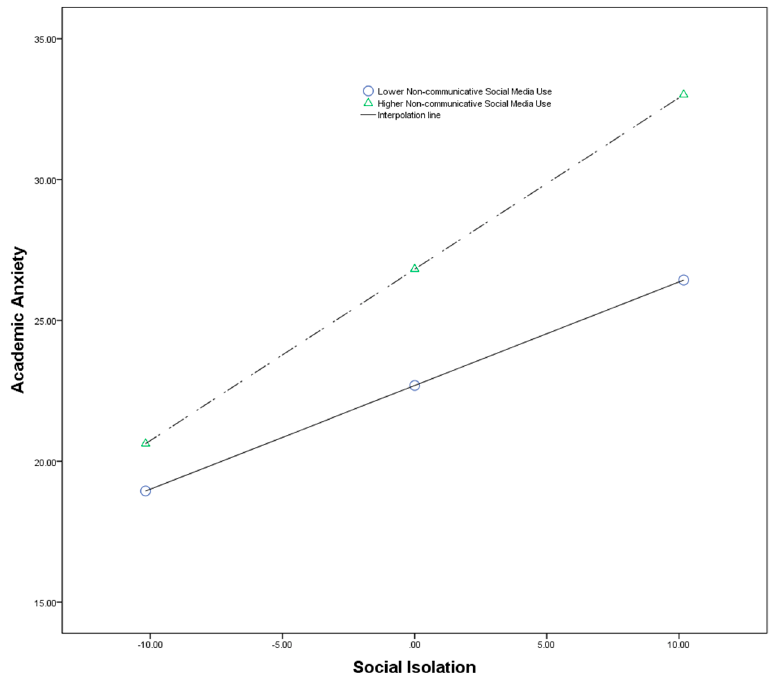
Figure 1. The moderating effect of the relationship between social isolation and academic anxiety. Table 5. Conditional indirect effects analysis.